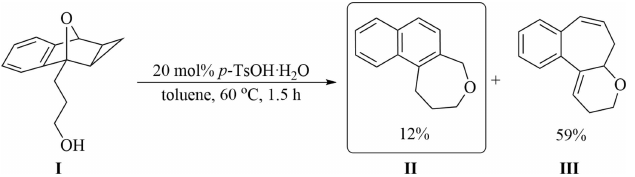
Figure 3 The reaction